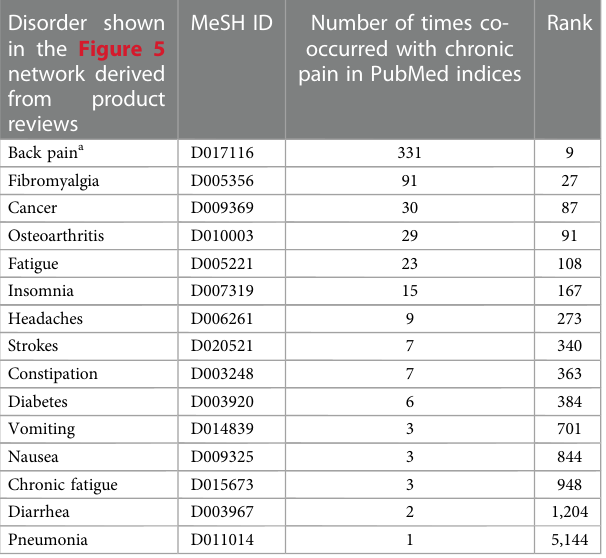
TABLE 1 Frequency and rank of the Figure 5 disorders as co-occurring MeSH terms with chronic pain (MeSH ID: D059350). Disorder shown in the Figure 5 network derived